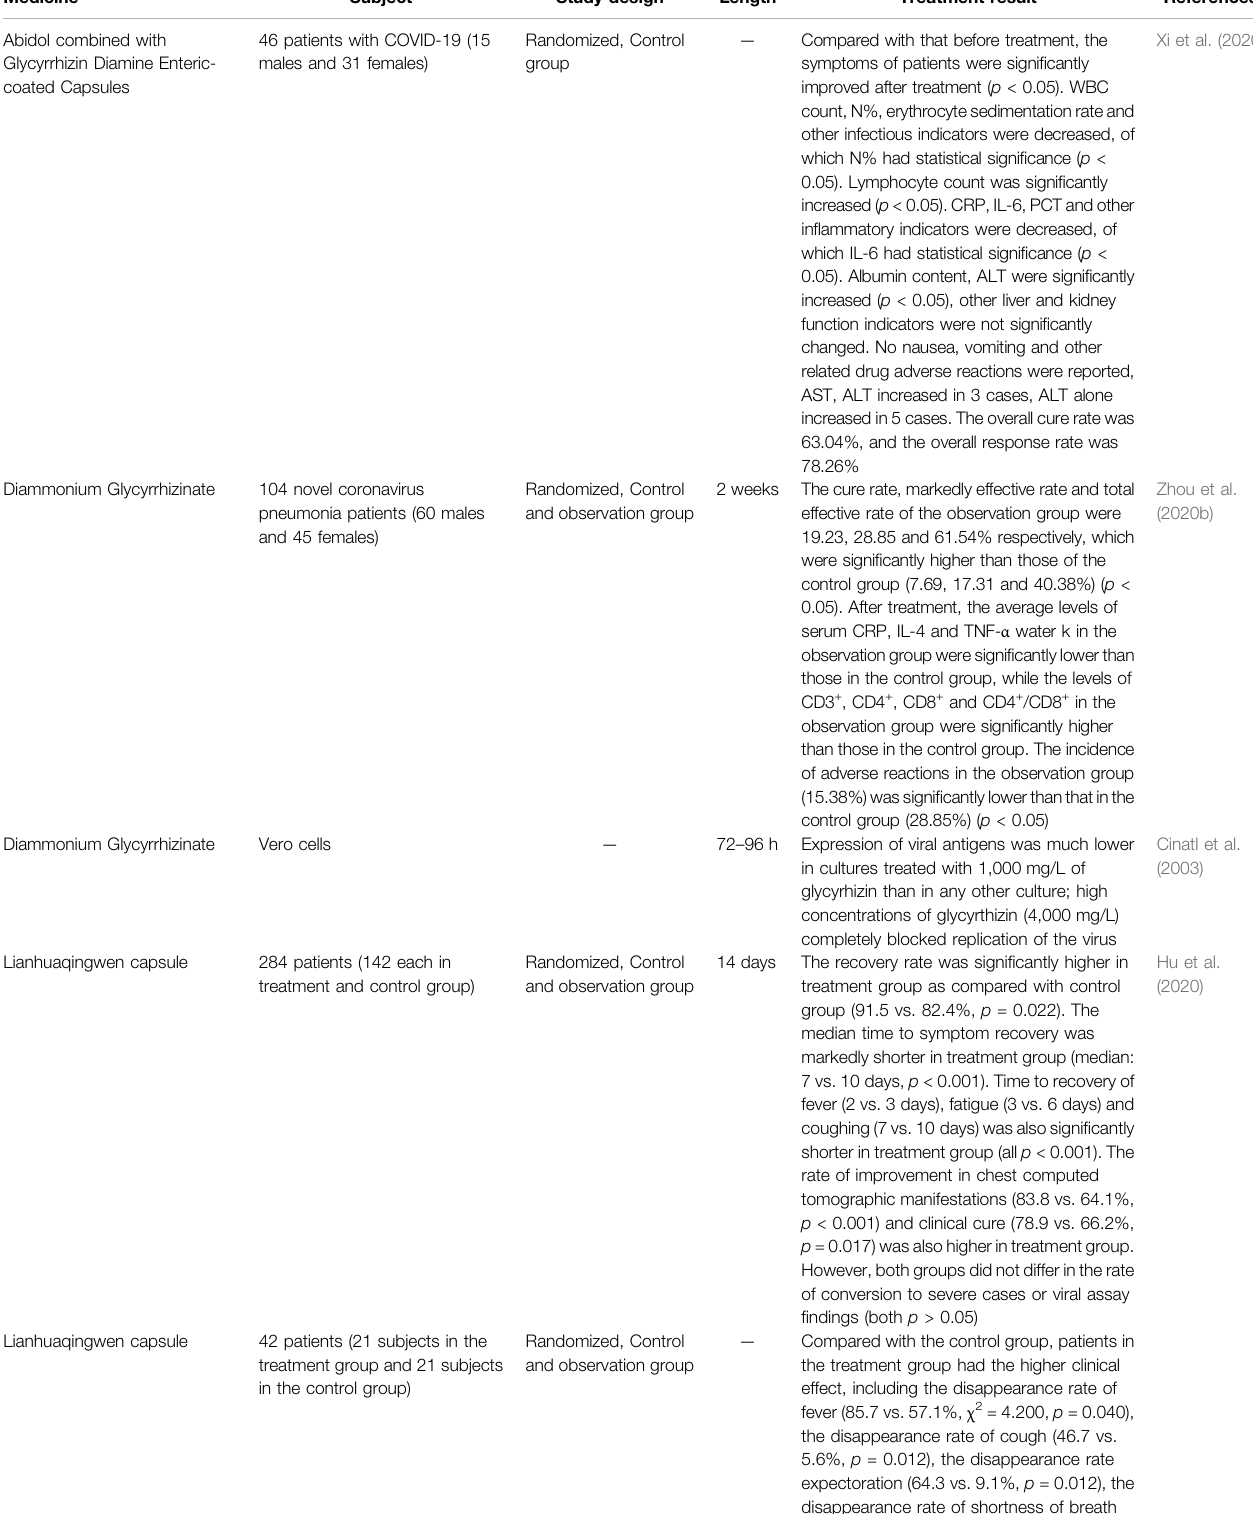
TABLE 4 | Clinical studies on the potential treatment of COVID-19 with licorice.